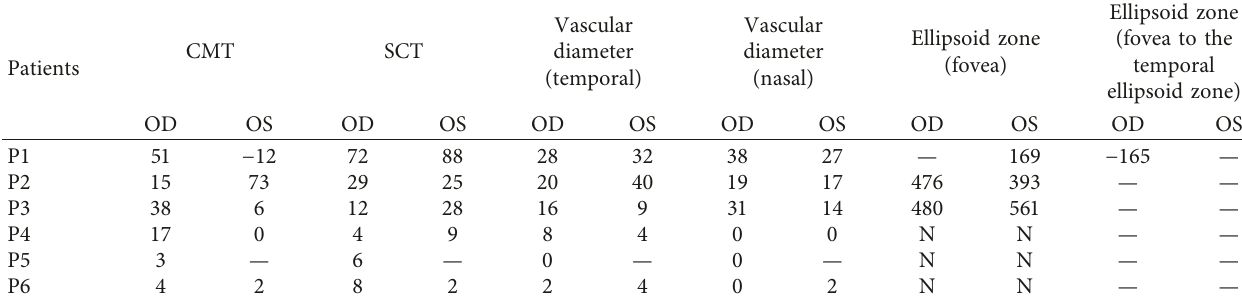
Table 2: Comparison of first and last SD-OCT results (Counting unit: μ m). CMT Patients